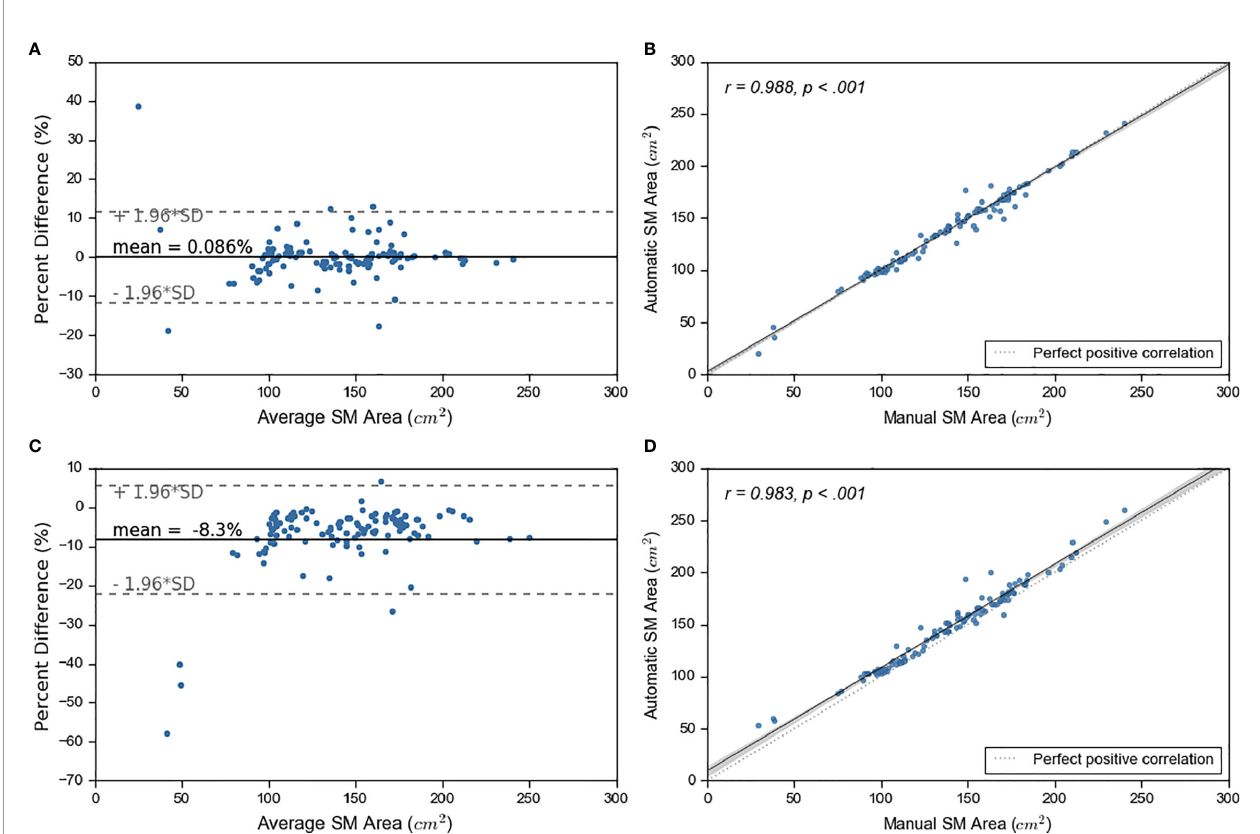
FIGURE 3 | Ensemble learning results. On left, sub fi gures (A, C) show Bland-Altman plots. On right, sub fi gures (B, D) show correlation plots. The top graphs show the results for average probability and bottom graphs show results for maximum probability maps.